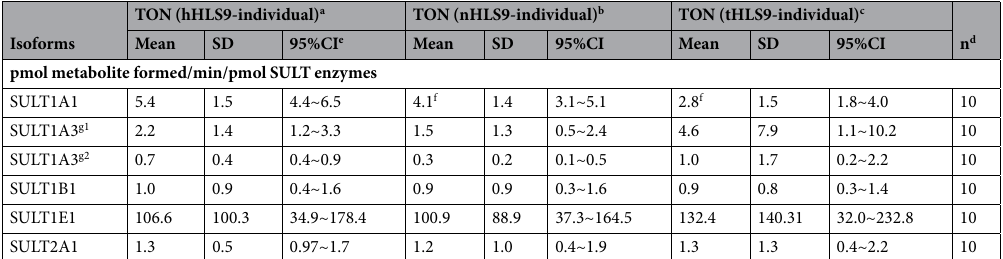
Table 5. Summary of turnover numbers of probe substrate metabolized by SULT enzymes. a,b,c Turnover numbers of probe substrates metabolized by SULT enzymes in hHLS9-individual, nHLS9-individual and tHLS9-individual, which were calculated as the ration of maimal metabolic rate (Vmax) to the total amount of SULTs enzyme that is shown in Figs 4 and 6. d Numbers of donors were calculating turnover numbers. e 95% CI represents the 95% confidence interval. Paired-samples t test or Wilcoxon sign rank test was used for data analysis. f Statistical significance ( P < 0.05). g1,g2 Dopamine was the probe substrate of the SULT1A3. Dopamine has two isomeride metabolites: dopamine 3-O-Sulfate and dopamine